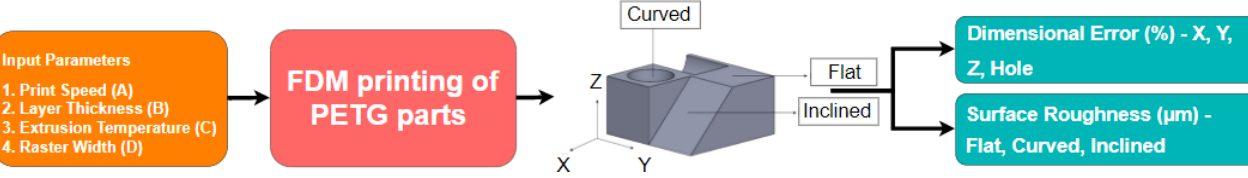
Figure 1. The selected input and output parameters for the FDM printing of PETG parts.